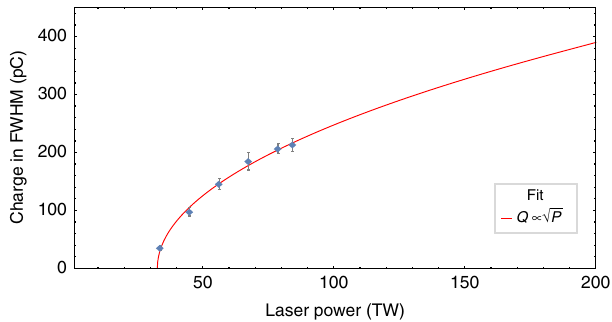
Fig. 6 Scaling of charge within FWHM with laser power. Circles represent measured data points taken with a nitrogen doping of 1% at a plasma density of 3.1 × 10 18 cm − 3 . The error bars represent the s.e.m. The red curve represents a fi t following the expected Q / energy spread measured to be ∼ 15% for all